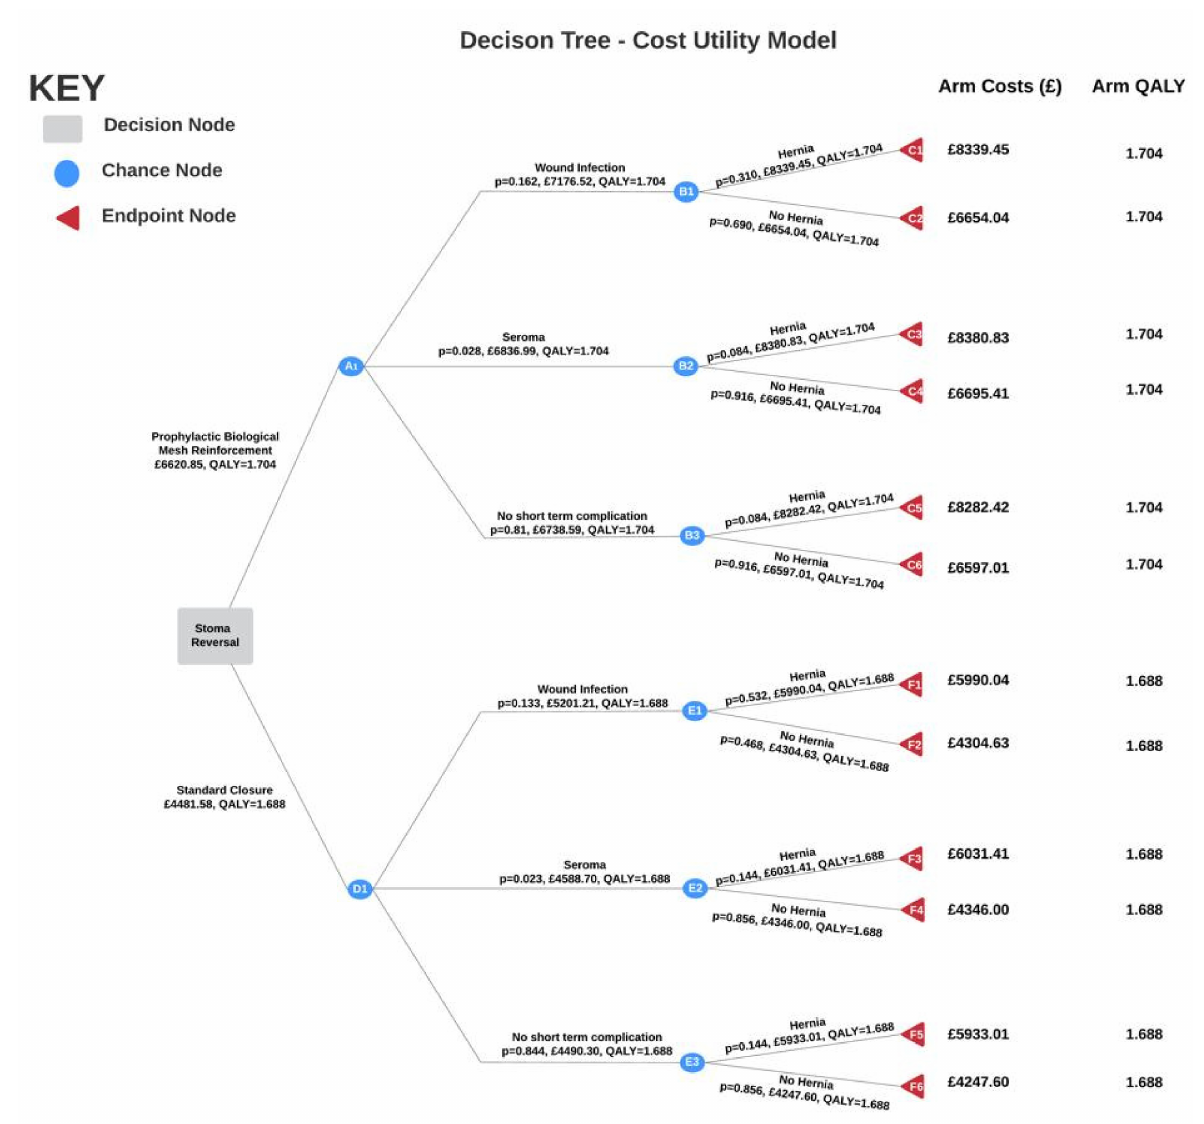
Figure 1. The decision tree compares prophylactic biological mesh reinforcement with standard suture